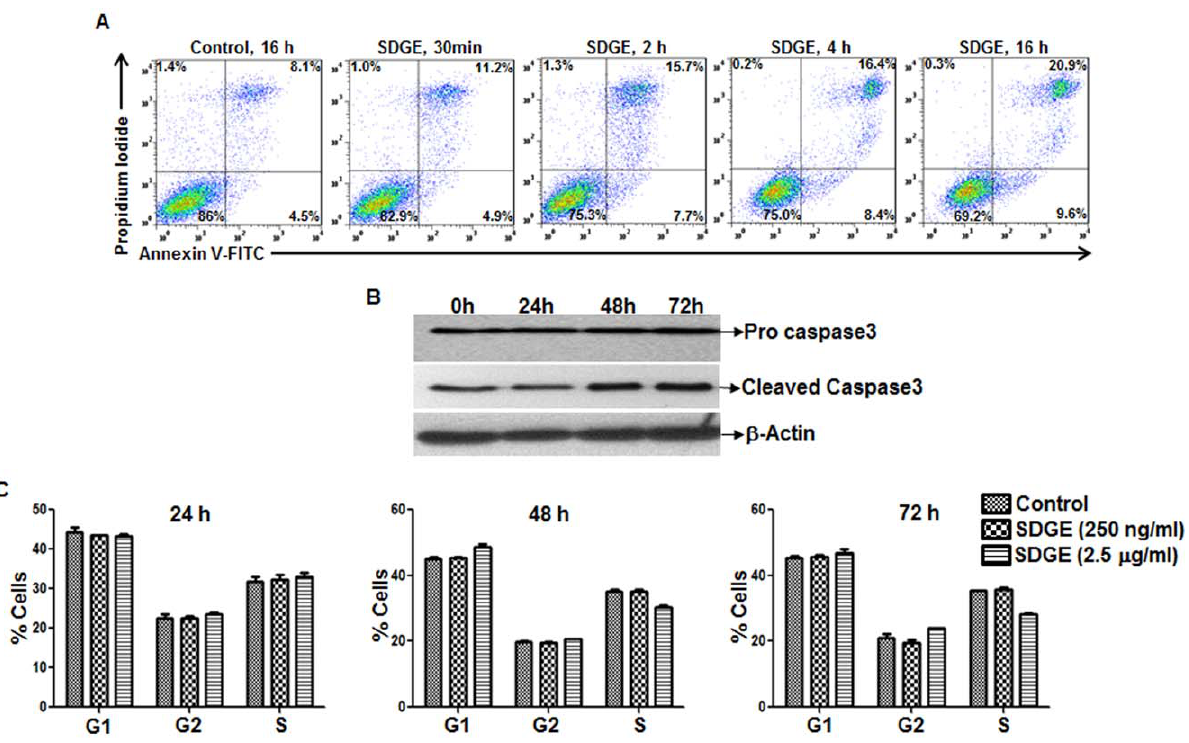
Figure 2. SDGE induces apoptosis in endometrial cancer cells. Ishikawa cells were treated with 250 ng/ml of SDGE for 30 min, 2 h, 4 h, and 16 h. After incubation with SDGE, cell survival was determined by labeling the cells with FITC-conjugated FITC-Annexin V and propidium iodide (A). The cells were analyzed by flow cytometry and cell death and apoptosis were identified as the events that were single positive for FITC-Annexin V (lower right quadrant) or double positive for both FITC-Annexin V and proidium iodide (upper right quadrant). SDGE-induced apoptotic cell death in the endometrial cancer cells was confirmed by detecting cleaved caspase 3 in western blot analysis (B). An increase in cleaved caspase 3 levels was observed when the Ishikawa cells were treated with SDGE (250 ng/ml) for 0, 24, 48, and 72 h. Data in A and B is representative of results obtained in three separate experiments,